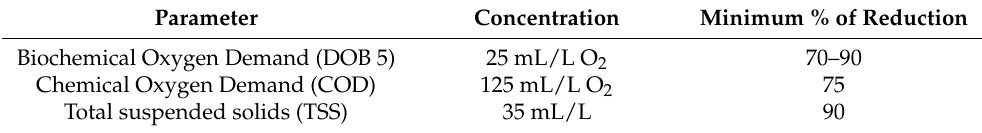
Table 2. Maximum concentrations and minimum percentage reductions for contaminant parameters